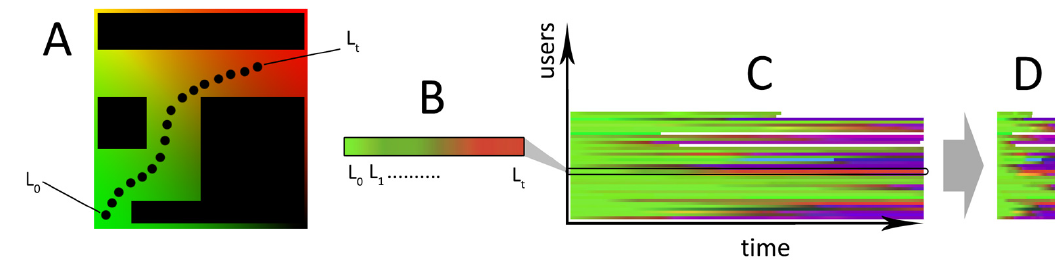
Figure 3. Quantized session atlas (QSA) layout. A sample locomotion from L 0 to L t locations, involving only XY-plane for clarity ( A ); encoding motion into color-coded signal ( B ); QSA layout ( C ) and temporal compression ( D